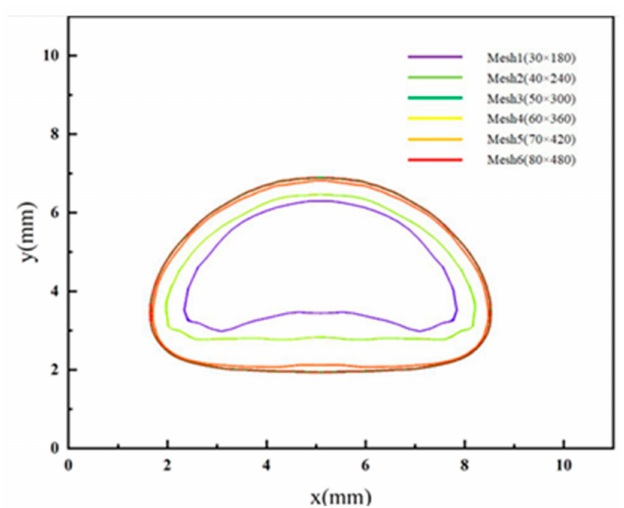
Figure 5. Grid independency check.